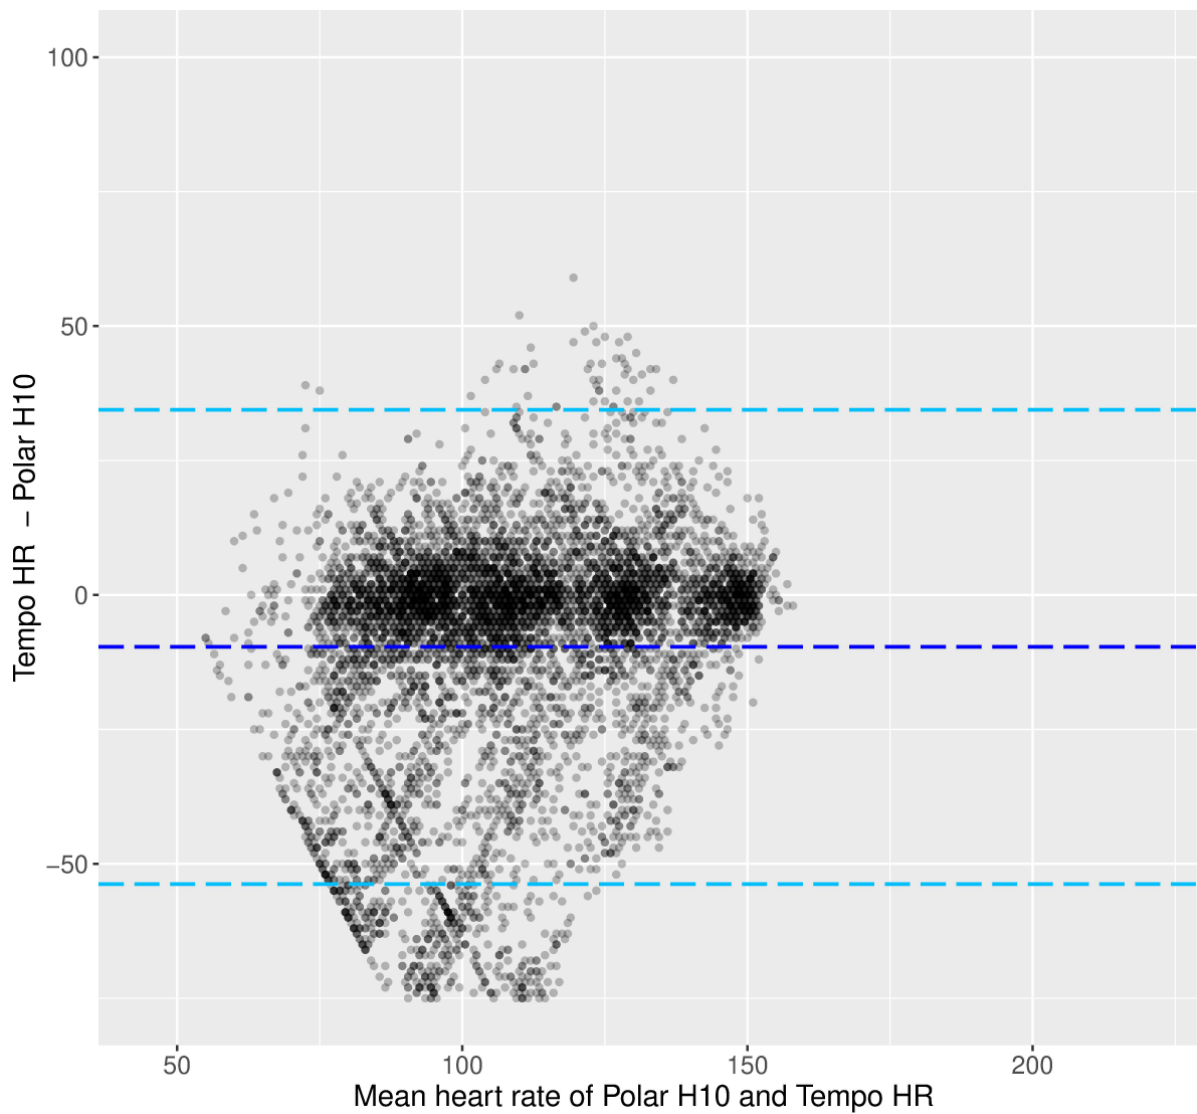
Figure 2. Laboratory phase: Bland-Altman plot between the heart rate data from the Polar H10 and the Tempo HR. Light blue dotted lines show the limits of agreement, and the dark blue dotted line shows the mean of the difference. HR: heart